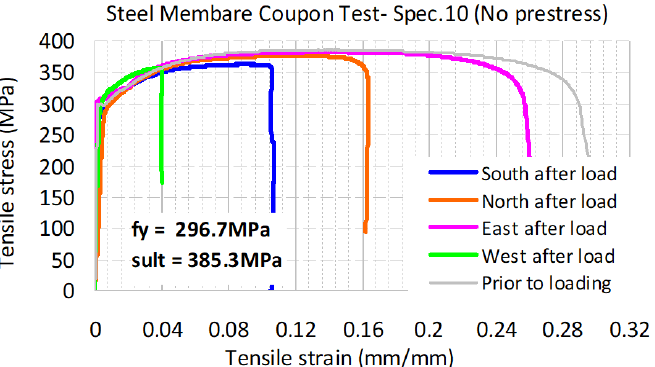
Figure 2. Cross ‐ section of the original PCCP with fully active prestressing wires.